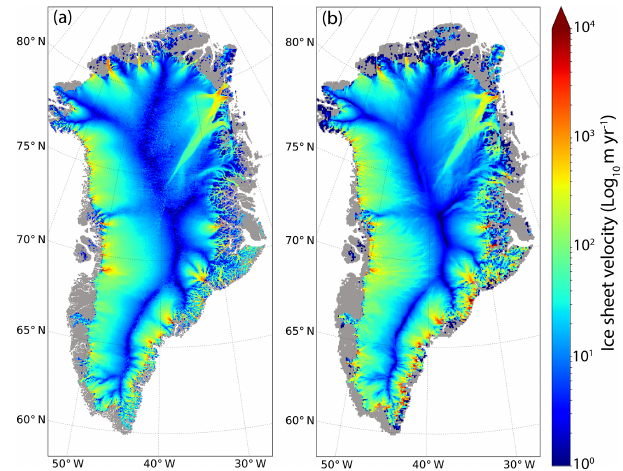
Figure 10. (a) Composite ice sheet velocity observation (myr − 1 ) from the NASA Making Earth System Data Records for Use in Research Environments (MEaSUREs) for the 2016–2018 mean pe- riod (Joughin et al., 2018). (b) Simulated surface ice velocity using Ef = 1 for Nb inv = 20 years, Nb free = 200 years and Nb cycle = 13 (corresponding to the one producing the minimal ice thickness RMSE; Table